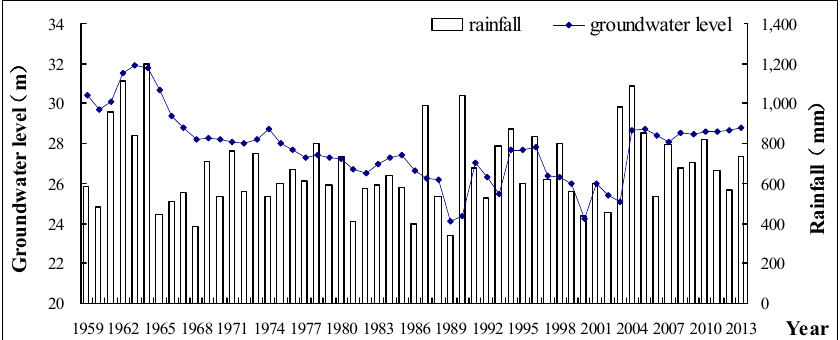
Figure 3. Precipitation and spring water level contrast curve, 1959 to 2013.